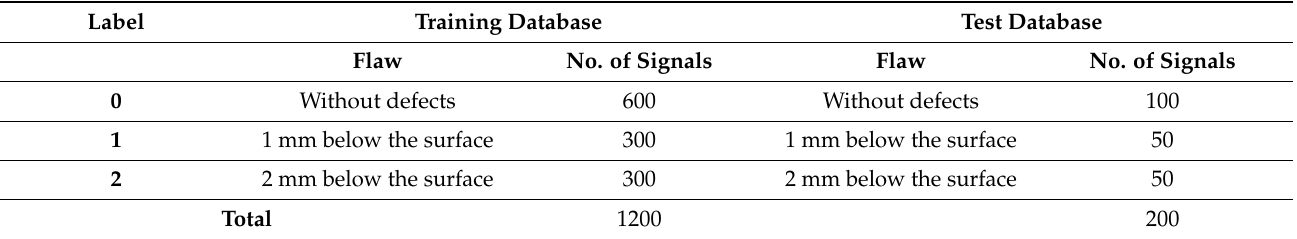
Table 1. Ultrasonic defect database.